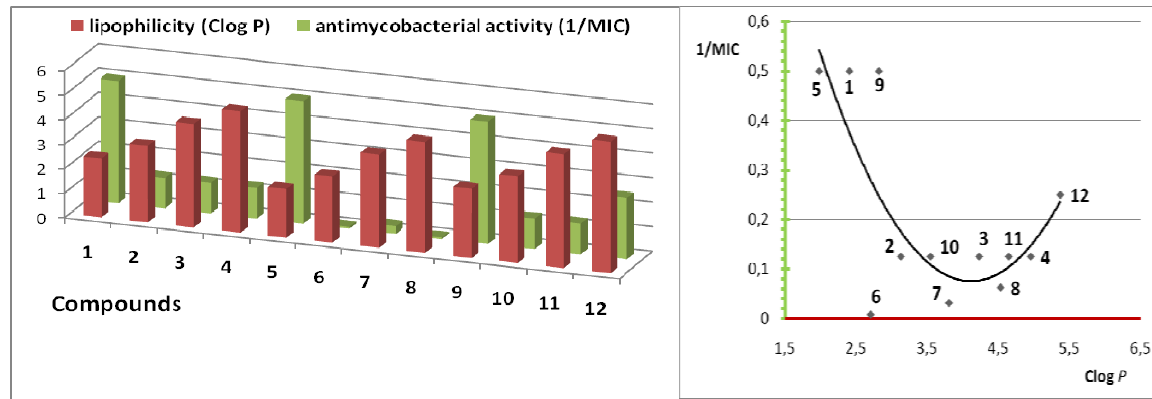
Figure 2. Antimycobacterial activity (against M. tuberculosis , 1/MIC) vs. lipophilicity (Clog P ) in compounds 1 - 12